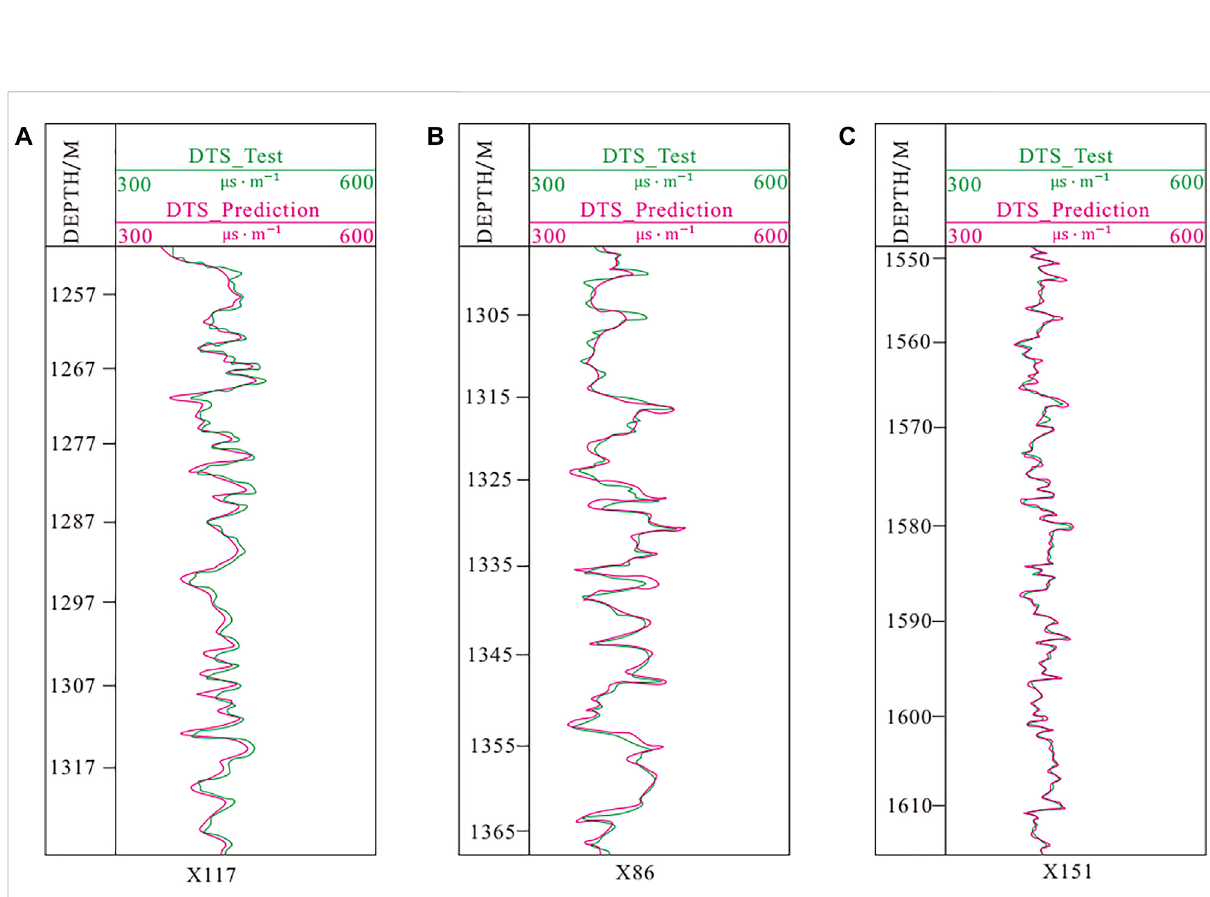
FIGURE 9 Comparison between the measured shear wave time difference and prediction in different wells.